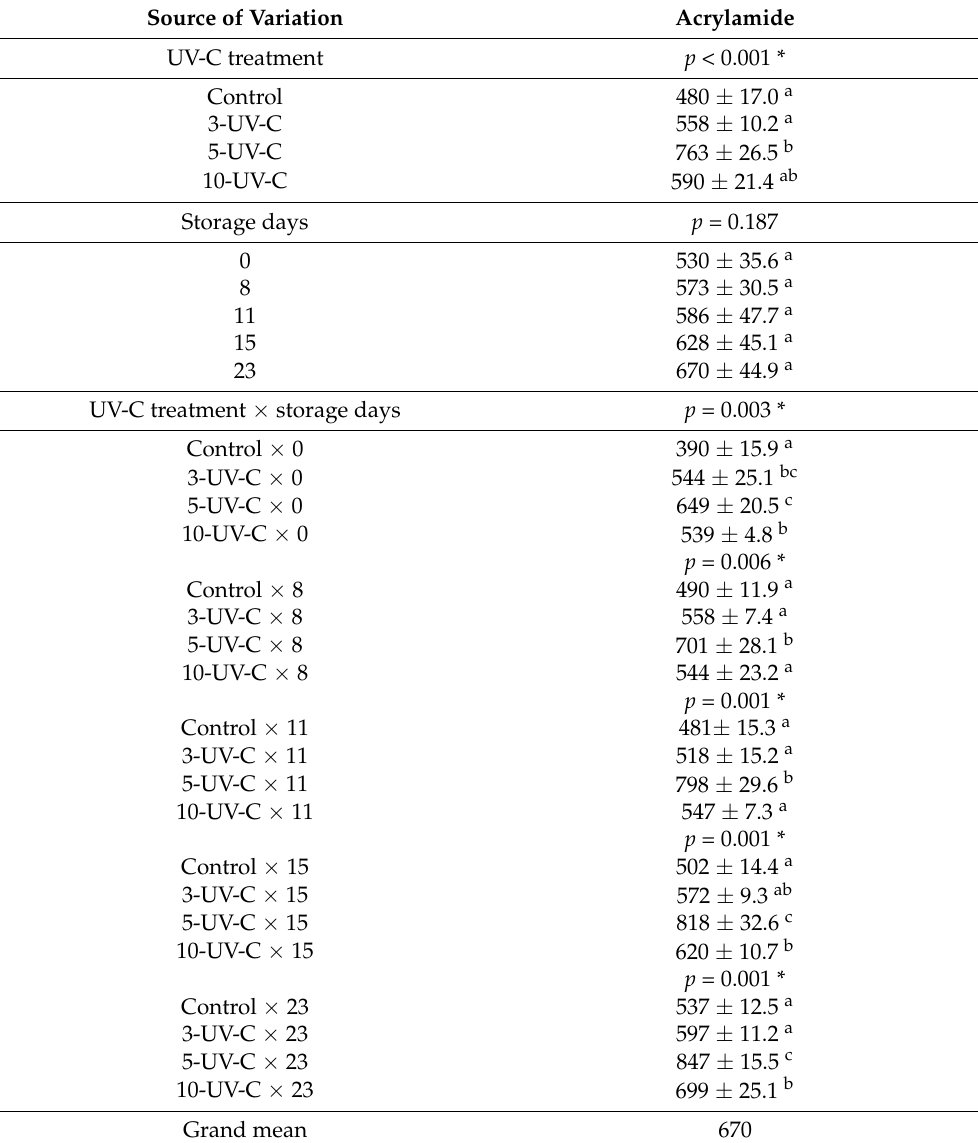
Table 2. The influence of UV-C treatment, storage, and cooking method on acrylamide ( µ g kg − 1 DW) in fried fresh-cut